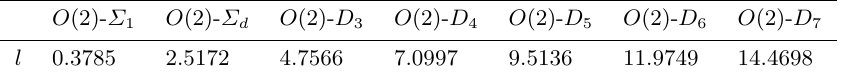
Table 2. Symmetry-breaking bifurcation point for l continuation with p = 3 , κ = − 1 and λ =